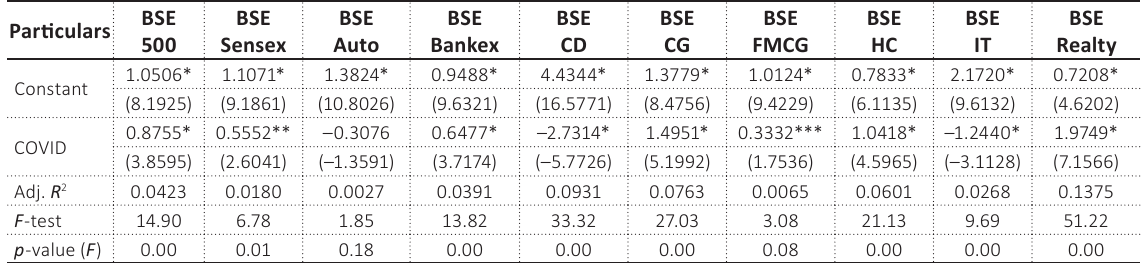
Table 6. Regression analysis: model 3 – for COVID-19 and kurtosis of the index returns Particulars